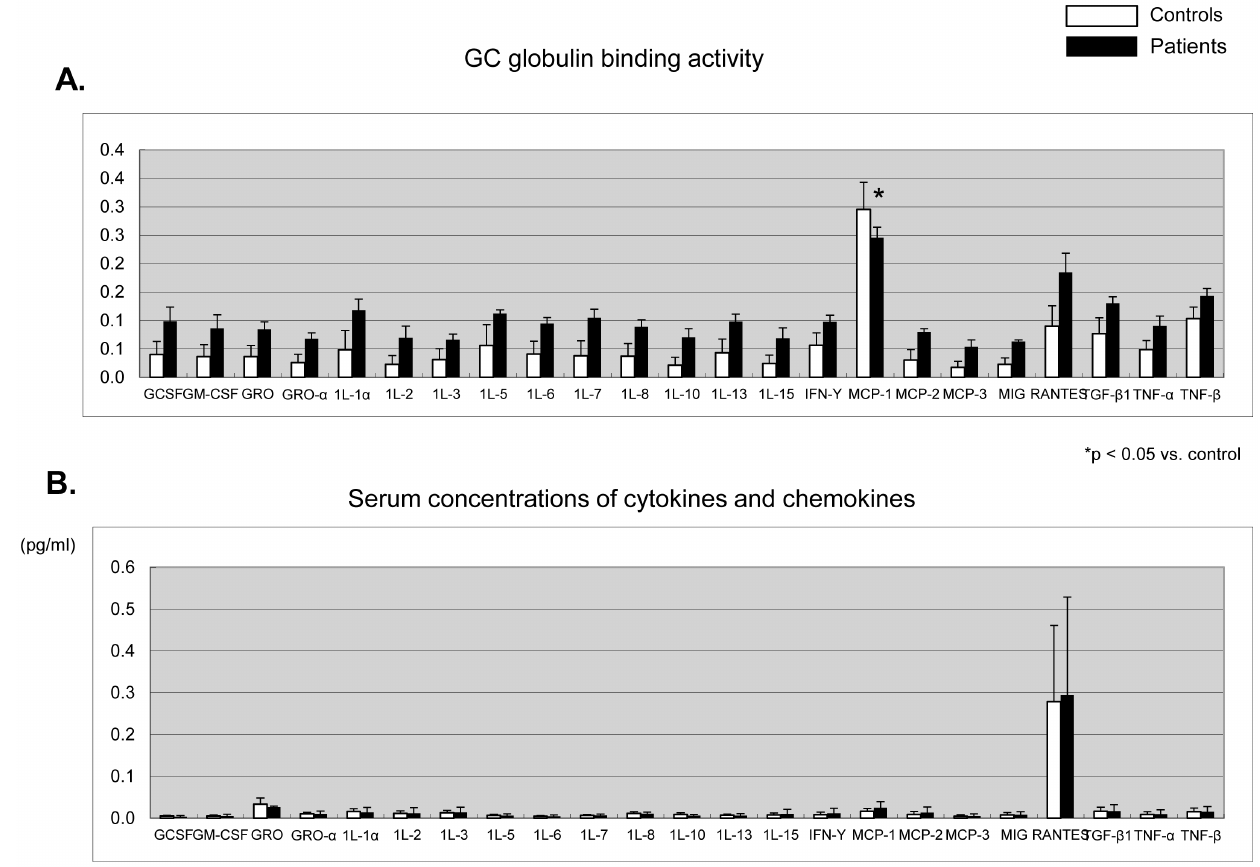
Figure 2. Cytokine antibody array for GC globulin binding activity and serum cytokines. The GC globulin binding affinity to MCP-1 was the highest among all the serum cytokines (A), while RANTES had the highest concentration among the serum cytokines (B). In sera from the patients, the GC globulin binding affinity to MCP-1 was significantly lower than that in sera from the control subjects (A), while the concentration of MCP-1 in sera from the patients tended to be lower than that in sera from the control subjects (B). White bars: healthy control subjects; Black bars: patients with severe myalgia and migraine. doi:10.1371/journal.pone.0105319.g002 PLOS ONE |